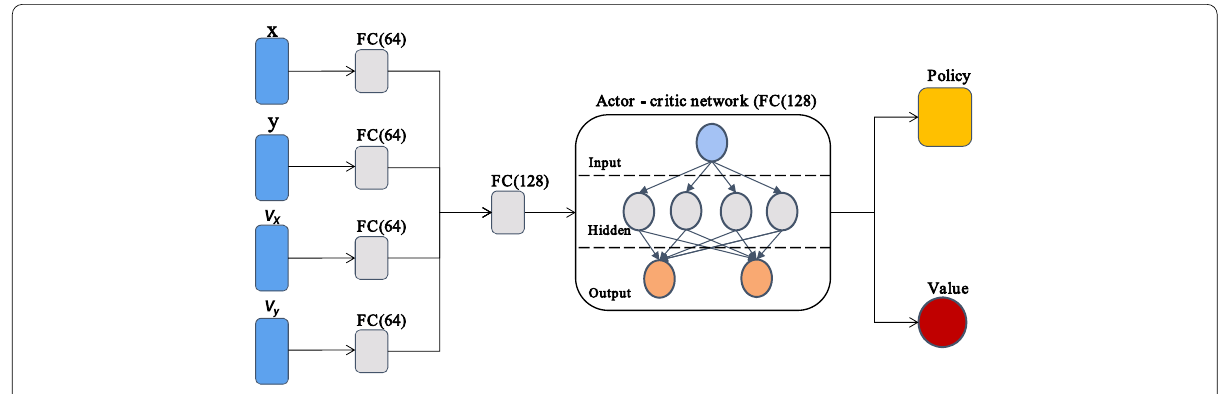
Figure 2 The architecture of the proposed MA2C network with shared actor-critic network design, where x and y are the longitudinal and lateral position of the observed vehicle relative to the ego vehicle, and v x and v y are the longitudinal and lateral speed of the observed vehicle relative to the ego vehicle